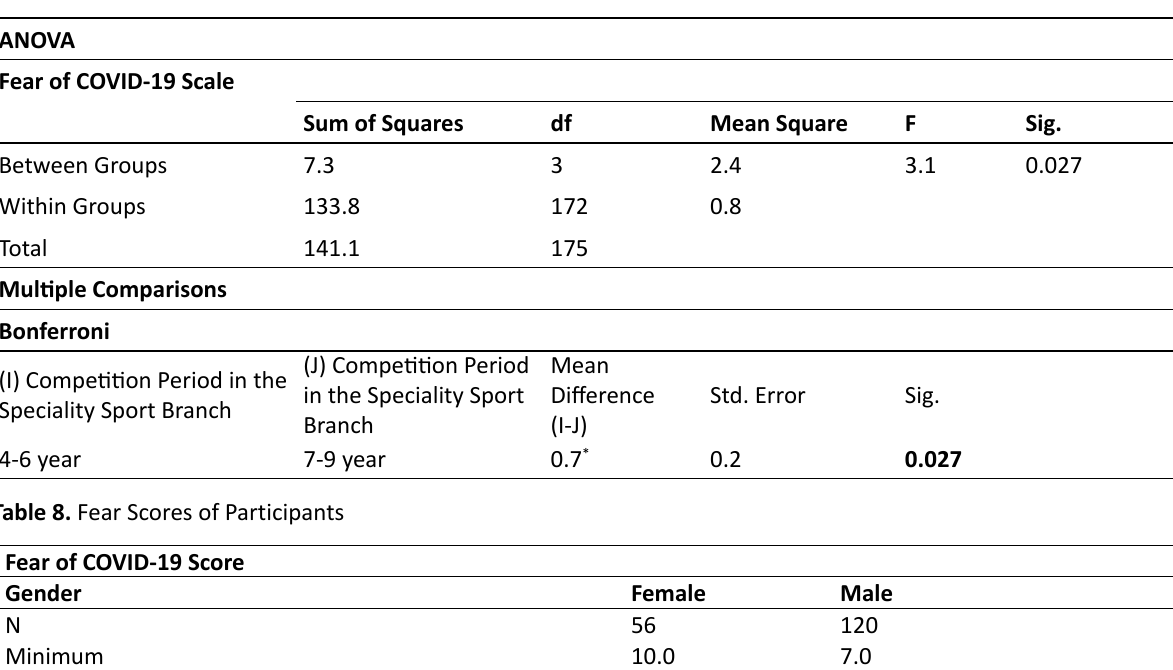
Table 7. One-Way ANOVA and Multiple Comparison Test (Bonferroni) Results According to the Variable of Competition History in Specialized Sports